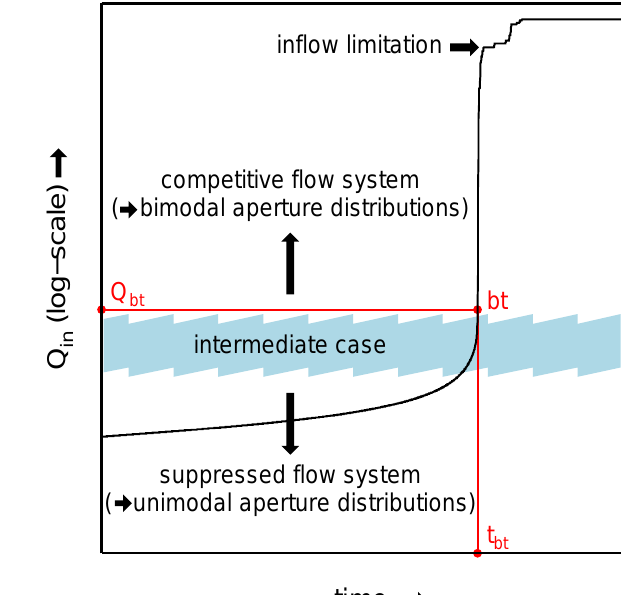
Fig. 4. Mean aperture distributions at late stages of karstification in models with low initial aperture heterogeneity and different maximum recharge.